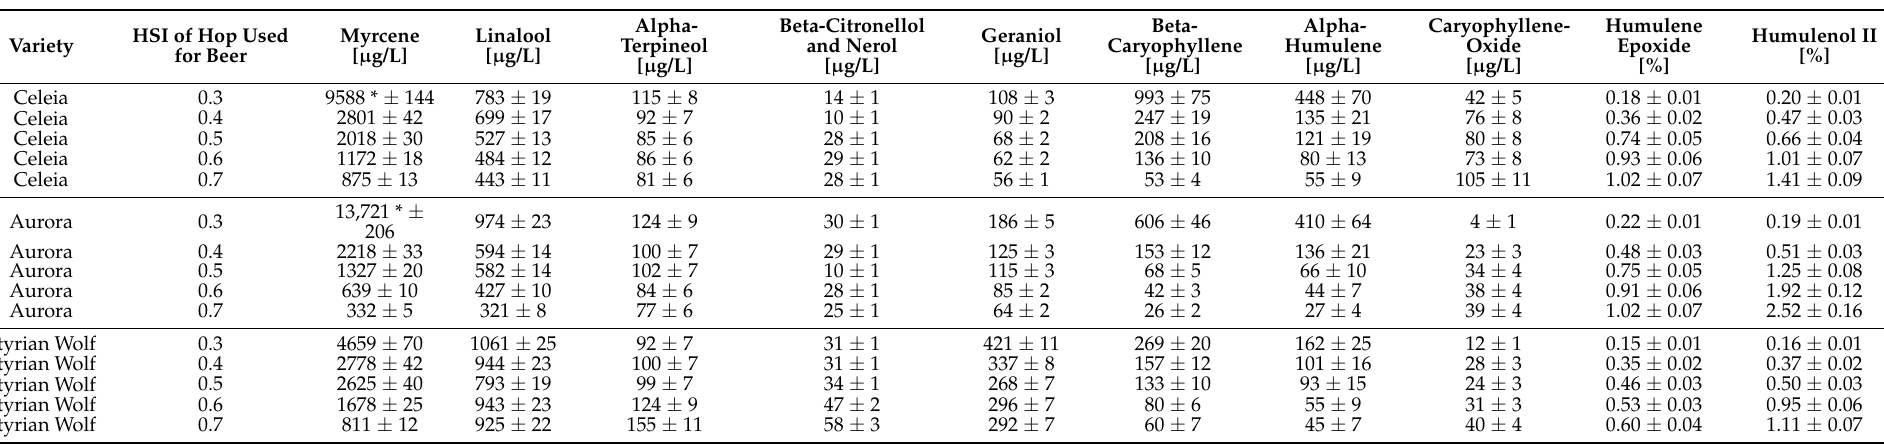
Table 3. Concentrations of hop volatiles in beer samples, presented as mean value ± standard